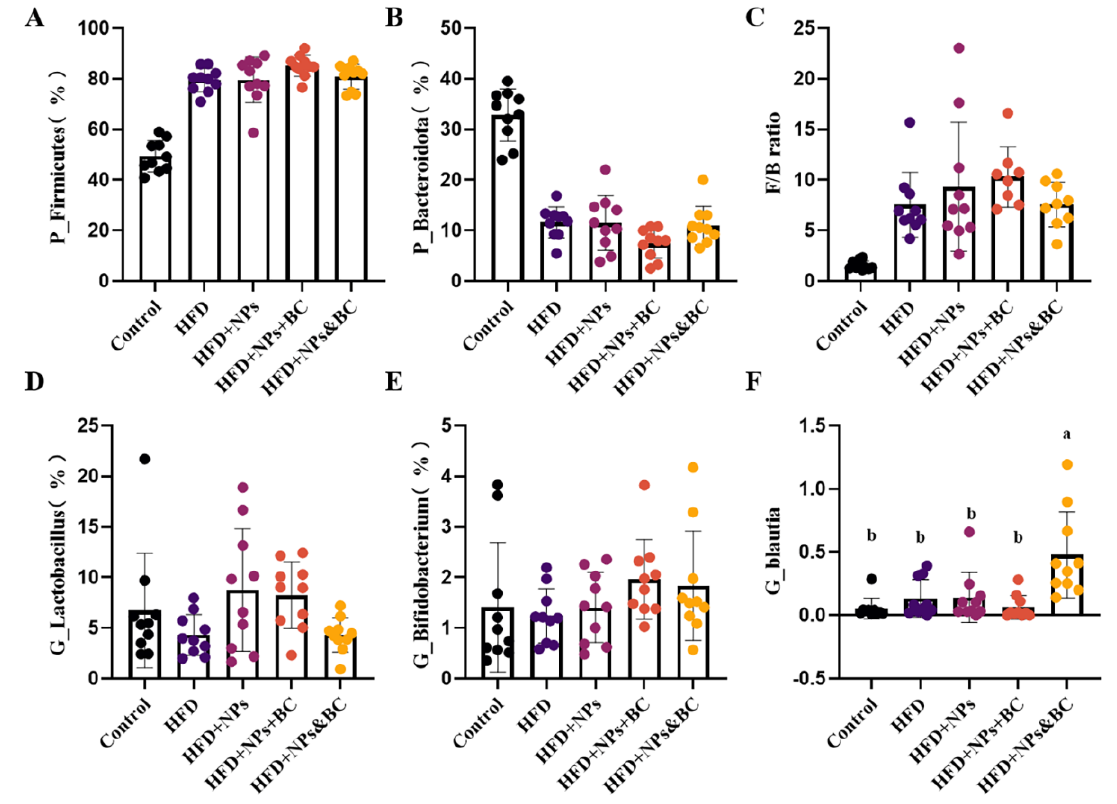
Figure 6. The relative abundance of microbiota at the phylum level ( A – C ) and the genus level ( D – F ). The different letters represent significant differences among groups ( p < 0.05).